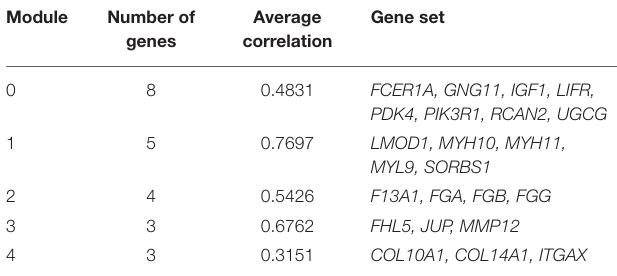
TABLE 1 | Genes in modules in FI network.